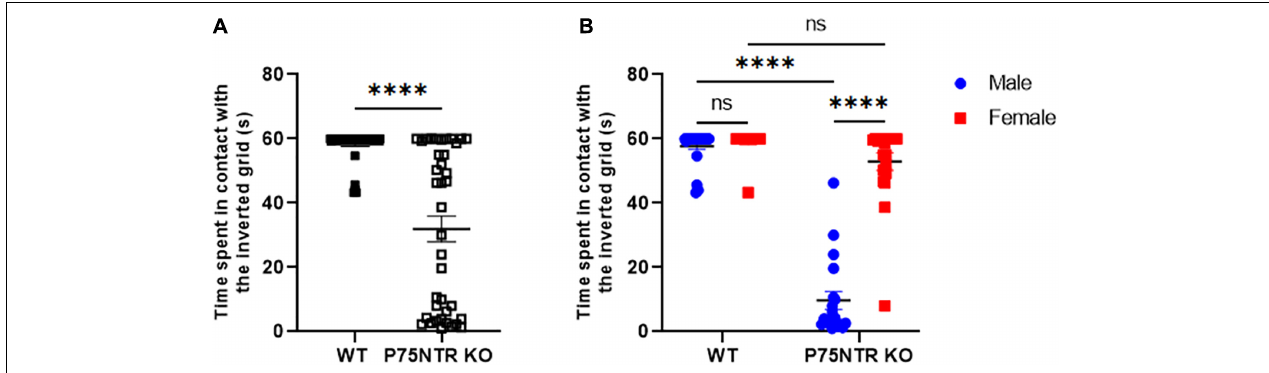
FIGURE 1 | Female p75NTR KO performed better than male p75NTR KO at the inverted grid test. (A) Each mouse was tested three times on the inverted grid test. Each point represents the average time a mouse spent in contact with the grid. The maximum time allowed on the grid was 60 s ( n = 43 WT and n = 39 p75NTR KO, **** p < 0.0001 T -test). (B) Same data as in panel (A) but separated by sex. Blue dots represent males; n = 24 mice WT and n = 19 p75NTR KO. Red squares represent females; n = 19 for WT and n = 20 for p75NTR KO. The black bar represents the mean for each group. ns, non-significant. **** p < 0.0001 two-way ANOVA followed by Tukey multiple comparison